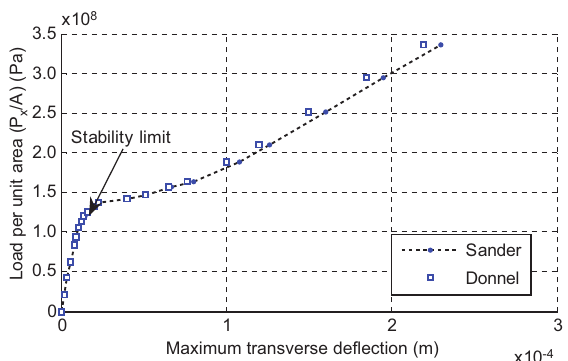
Figure A-2 Load-defl ection curve for uniform-thickness curved plate with ply confi guration [0